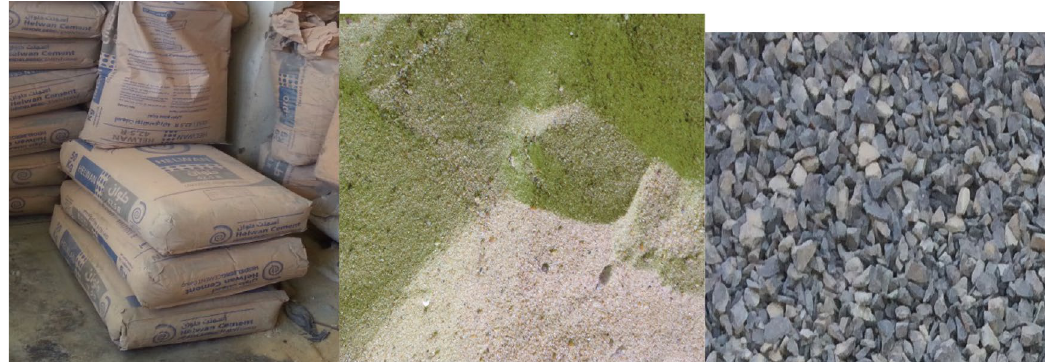
Fig. 2 Cement, sand, and gravel used in the experimental